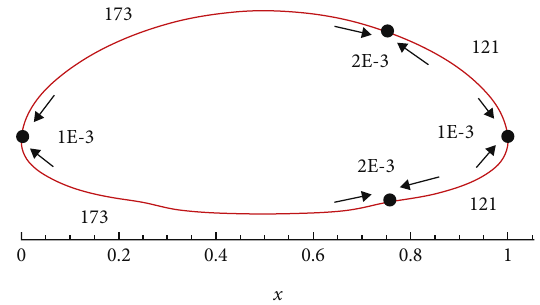
Figure 7: Grid distribution for medium grid.